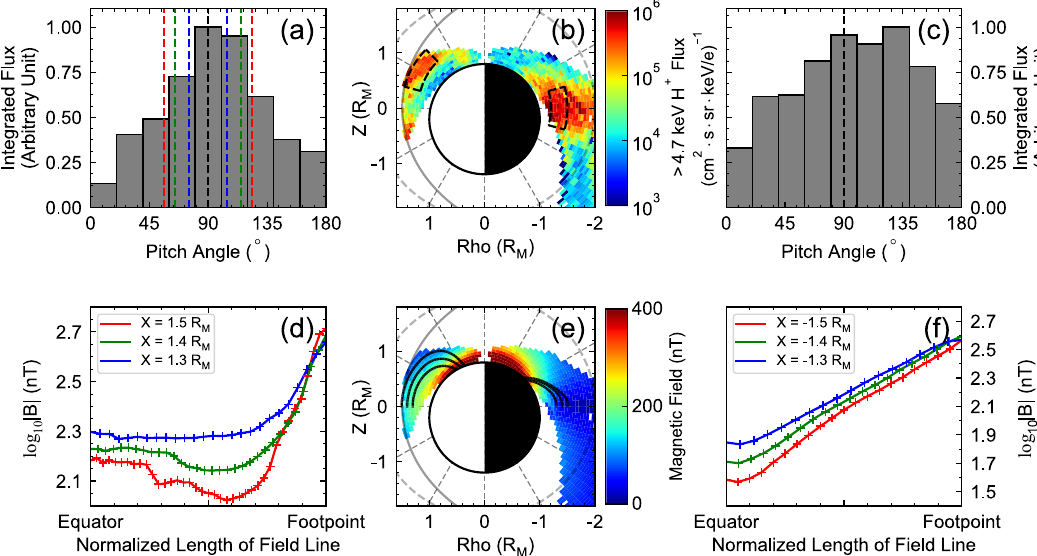
Fig. 4 Pitch angle distributions and fi eld line tracing results. a The pitch angle distribution of energetic protons in the dayside high latitude ffiffiffiffiffiffiffiffiffiffiffiffiffiffiffiffiffiffiffiffiffi q magnetosphere (observations inside the area marked by the black box on the dayside in Panel b ). b The spatial distribution of the energetic proton fl ux in the day-night meridian plane (Rho ¼ X (cid:3) 1 þ Y 2 = X 2 ), adopted from Fig. 2b. c The pitch angle distribution of energetic protons in the nightside equatorial magnetosphere (observations inside the area marked by the black box on the nightside in Panel b . d Magnetic fi eld strength variations along the fi eld lines ð Y ¼ Z ¼ 0 Þ . e Observed mean magnetic fi eld strength distribution (colour plots) and magnetic fi eld line tracing results originating from X ¼ 1 : 3 ; 1 : 4 ; 1 : 5 R M (the overplotted black lines). f Magnetic fi eld strength variations along the fi eld lines originating from X ¼ (cid:4) 1 : 3 ; (cid:4) 1 : 4 ; (cid:4) 1 : 5 R M ð Y ¼ Z ¼ 0 Þ . See Supplementary Fig. 10 for the colour alternative version of this fi